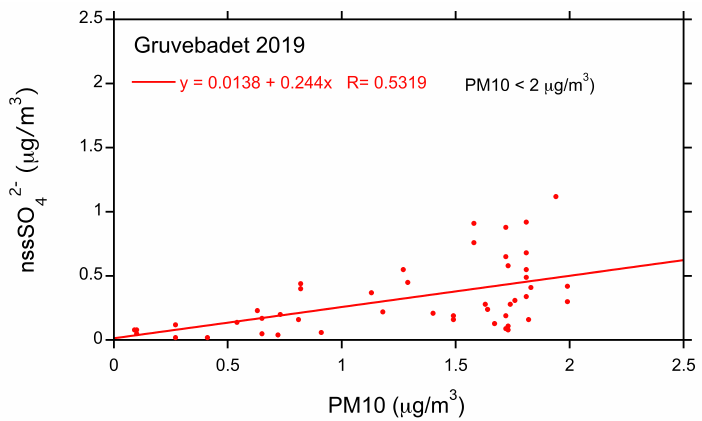
concentration and PM10 from Gruvebadet station for low 4